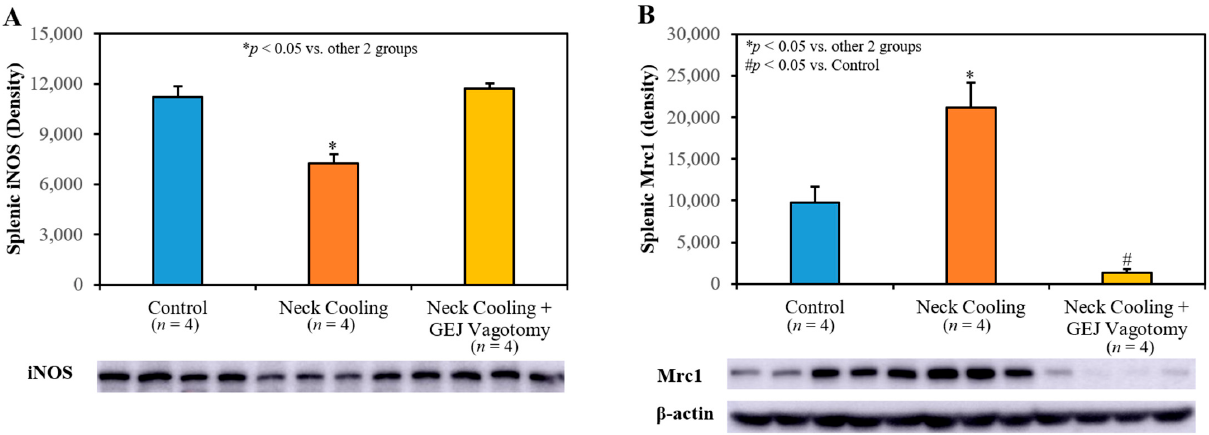
Figure 8. Splenic tissue expression of ( A ) iNOS and ( B ) Mrc1 protein at 3 h after CLI.